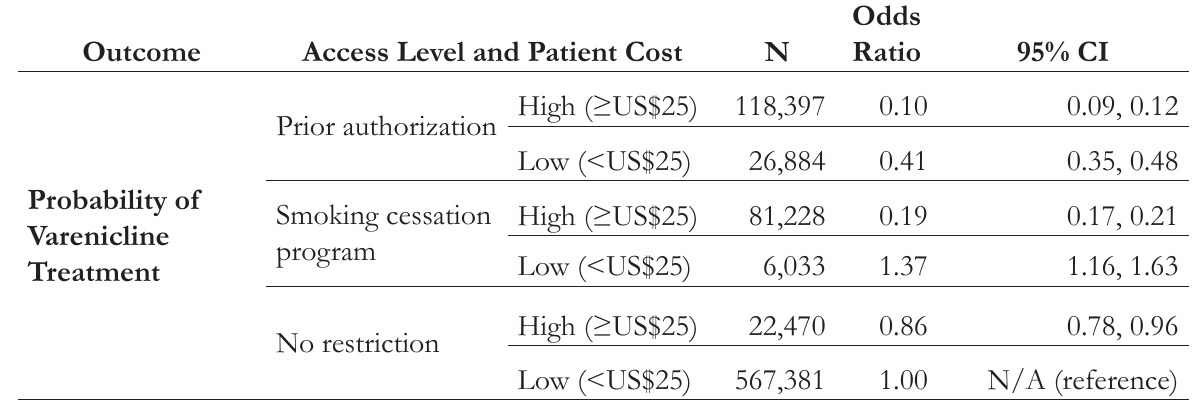
Table 2. Impact of Access Restrictions and Out-of-pocket Cost of Varenicline